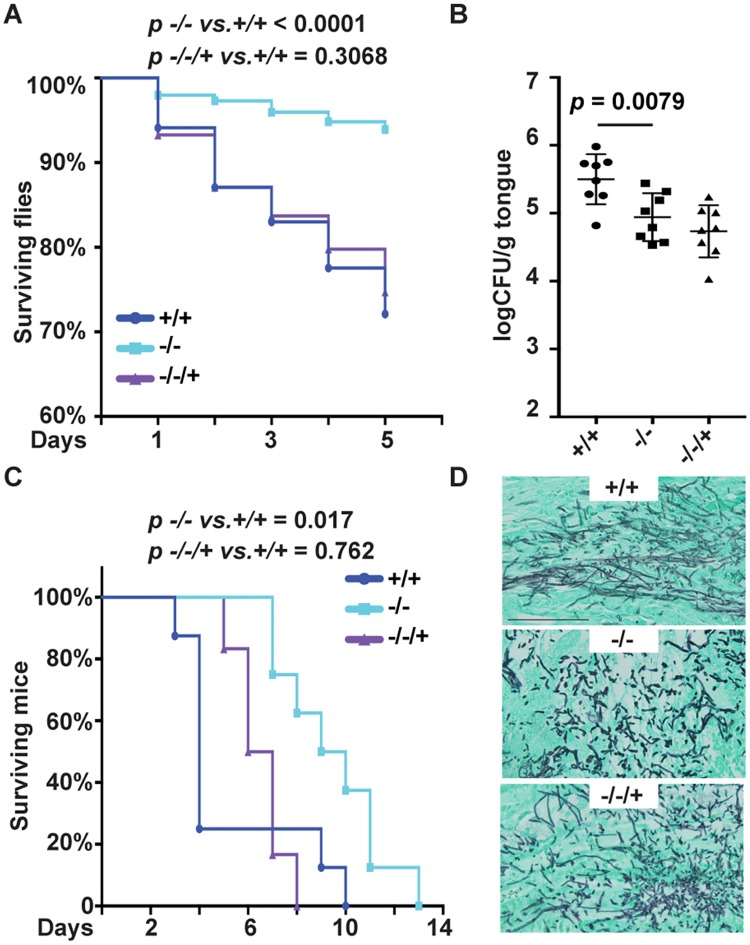
Virulence is attenuated in C. albicans cells lacking PHO84.(A) Percentage of surviving Drosophila mlanogaster after infection with cells of the PHO84 genotypes +/+, JKC915; -/-, JKC1450 and -/-/+, JKC1588 respectively. The flies were injected with 50 nl fungal cell suspensions with a micro-injector. At least 3 (up to 7) biological replicates and 6–15 technical replicates per strain were performed. (B) Oral fungal burden of mice with oropharyngeal candidiasis was calculated by enumerating CFU per gram tongue tissue after 5 days of infection. Each dot represents the tissue fungal burden of one mouse. (C) Kaplan-Meier survival plot of mice with disseminated candidiasis. Eight mice per strain were injected with strains as in A respectively. (D) Kidneys from +/+, -/- and -/-/+ infected mice were isolated and sections stained with Gomori Methenamine Silver. Size bar 0.1 mm.